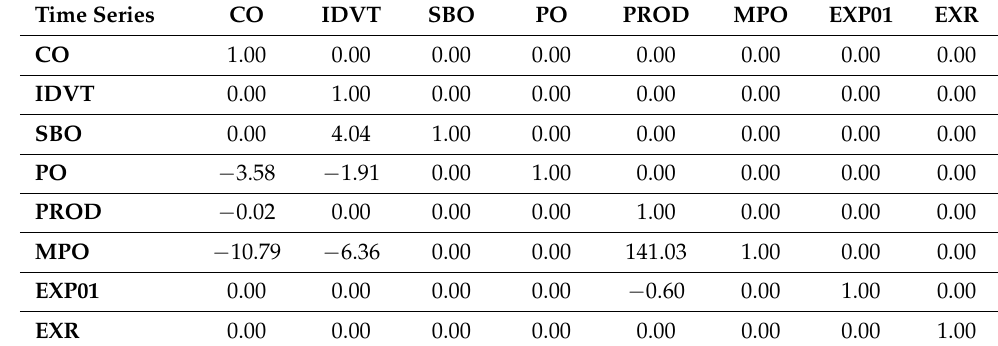
Table 9. Structural matrix A estimated under the restrictions in Table 8.